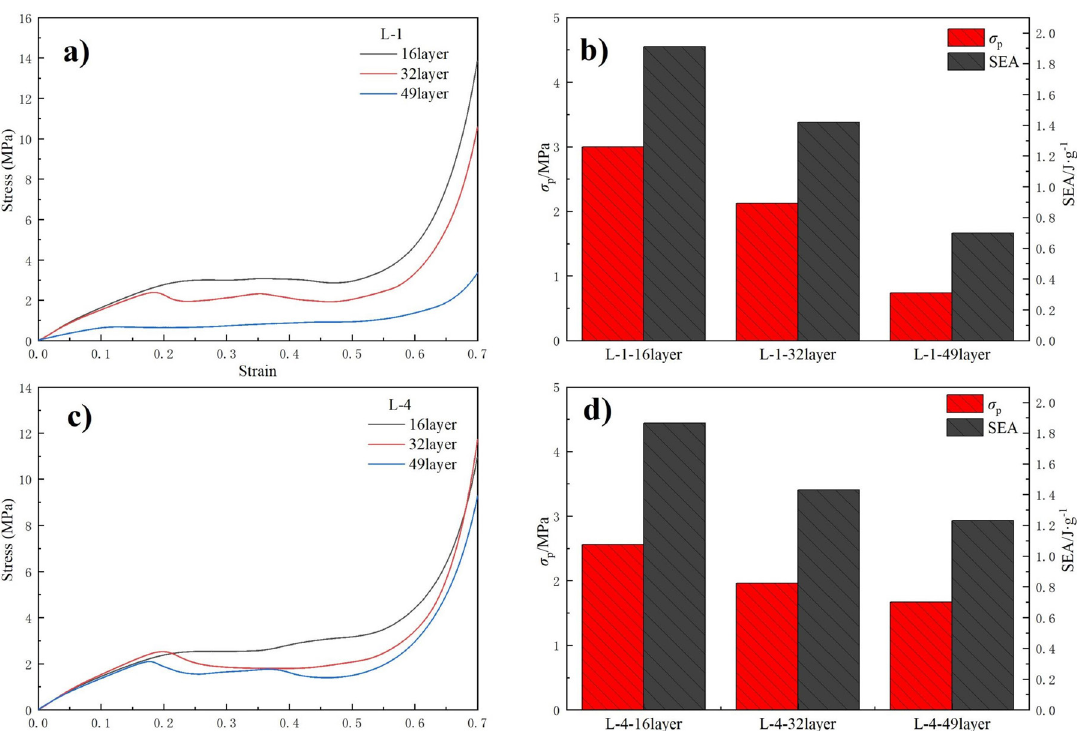
Figure 15. a) Stress-strain curves of different lattice height (L-1), b) Platform stress and SEA of different lattice height(L-1), c) Stress- strain curves of different lattice height (L-4), d) Platform stress and SEA of different lattice height